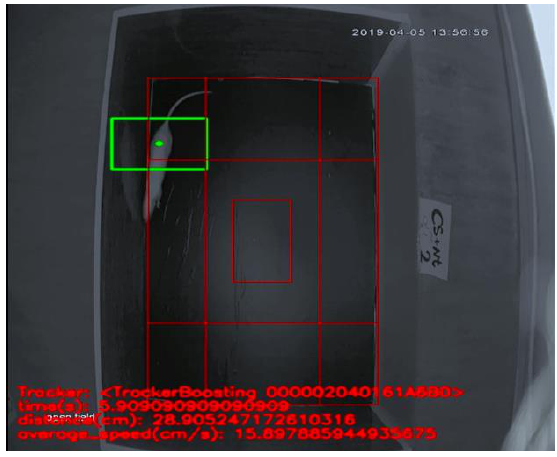
Figure 2. Open field test performance and box.